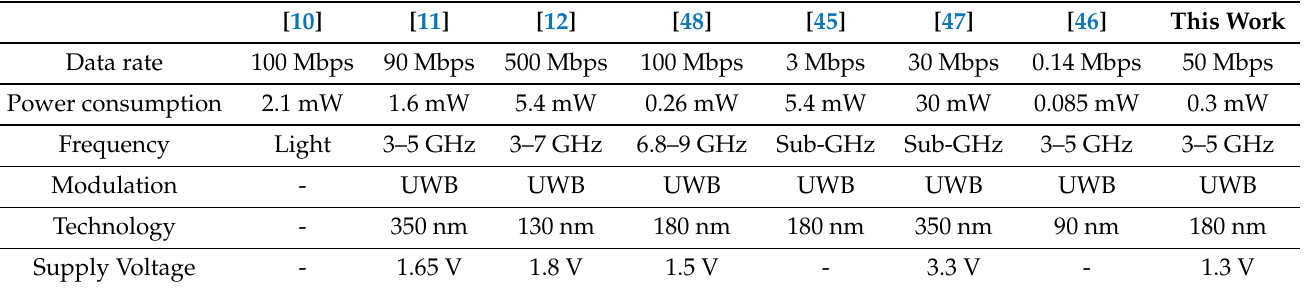
Table 3. Comparison with other medical implant transmitters.